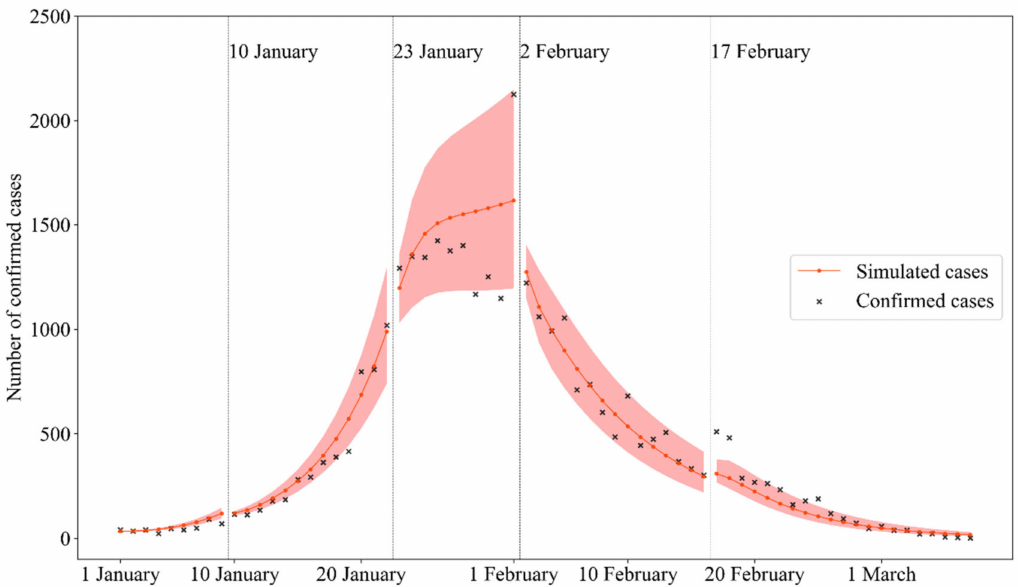
Figure 3. Simulated cases from the five-stage model were verified with the COVID-19 confirmed cases in Wuhan. The confirmed case data comes from The Chinese Centers for Disease Control and Prevention. The fitting technique of the five-stage model was introduced in Section